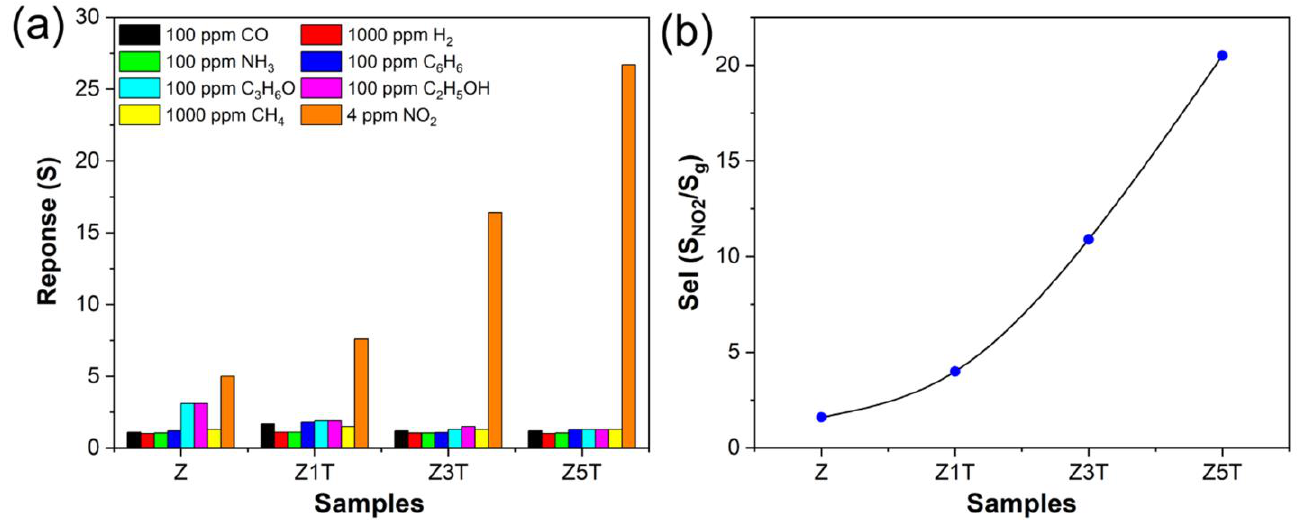
Figure 8. Selectivity histogram constructed from the responses to different gases (H 2 , CH 4 , CO, C 6 H 6 , NH 3 , ethanol, acetone and NO 2 ) ( a ) and the dependence of the selectivity coefficient (Sel) of the receptor layers of samples Z, Z1T, Z3T and Z5T ( b ); detection temperature 200 °C.